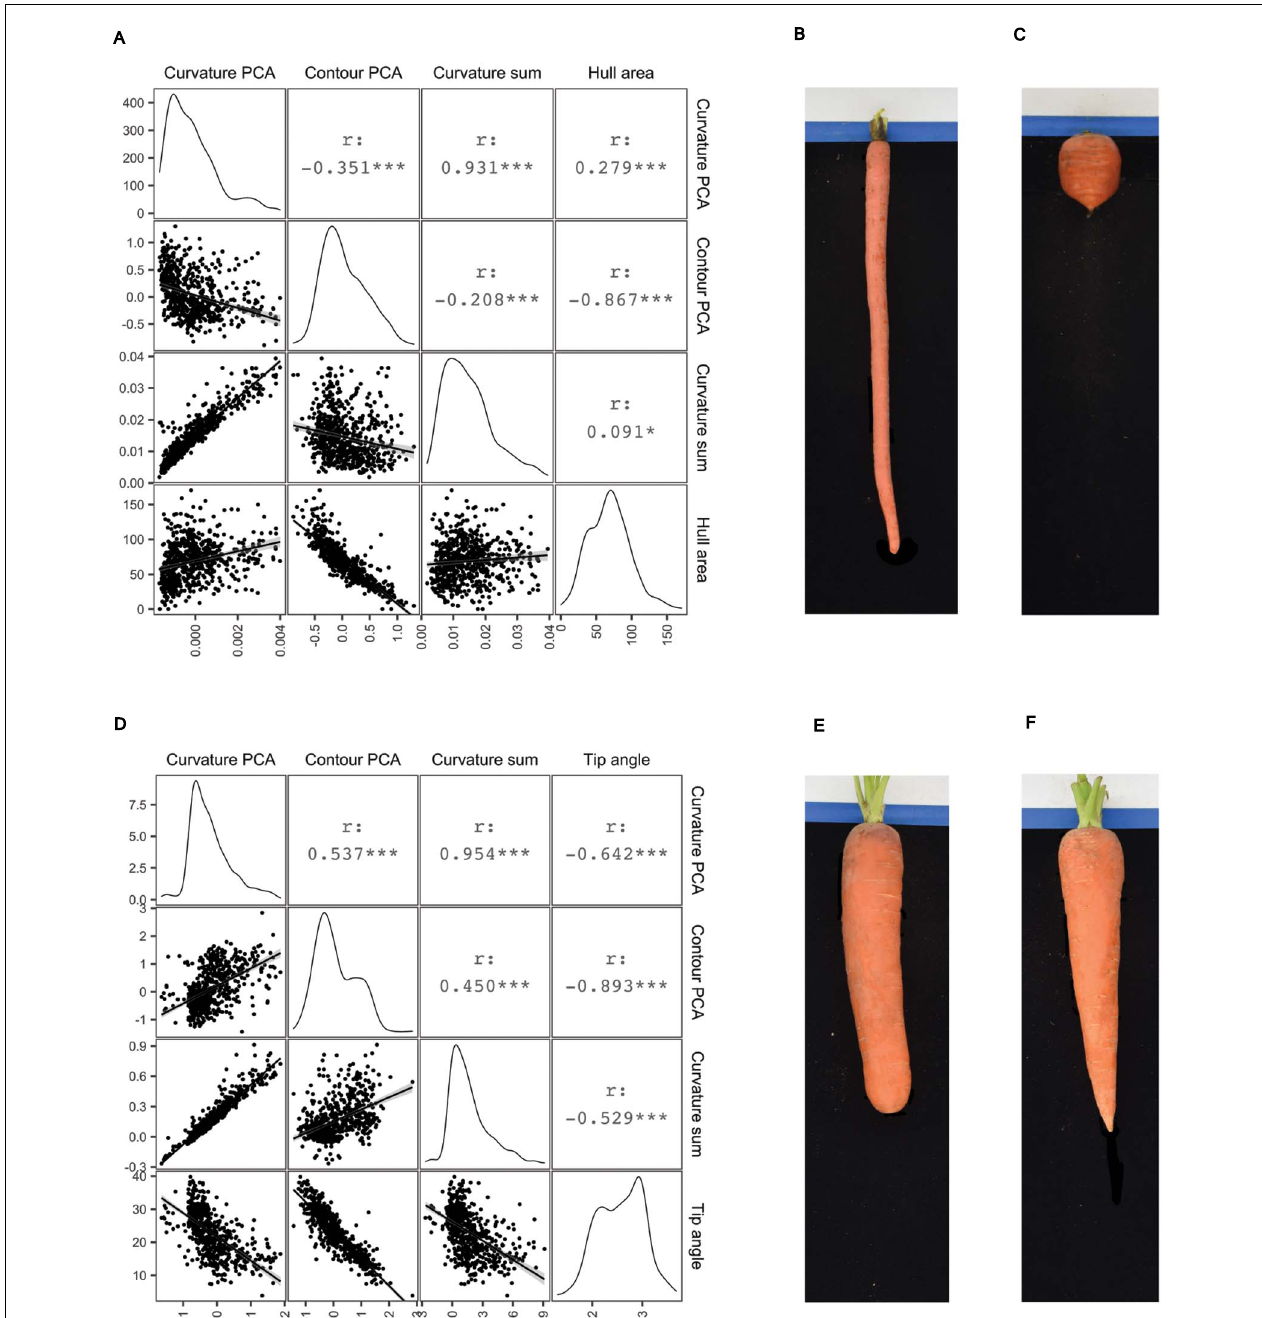
FIGURE 4 | Correlograms comparing several measures of shoulder shape (A) and tip shape (D) : PC1 scores derived from curvature values (“Curvature PCA”), PC1 scores derive from normalized contours (“Contour PCA”), the sum of curvature values, and either shoulder hull area (A) or tip angle (D) . For Pearson correlation coefficients ( r ) shown above the diagonal, *** p < 0.001; * p < 0.1. Images on right illustrate representative roots drawn from the extremes of the first principal component scores corresponding to shoulder curvature values (B,C) and tip curvature values (E,F) .